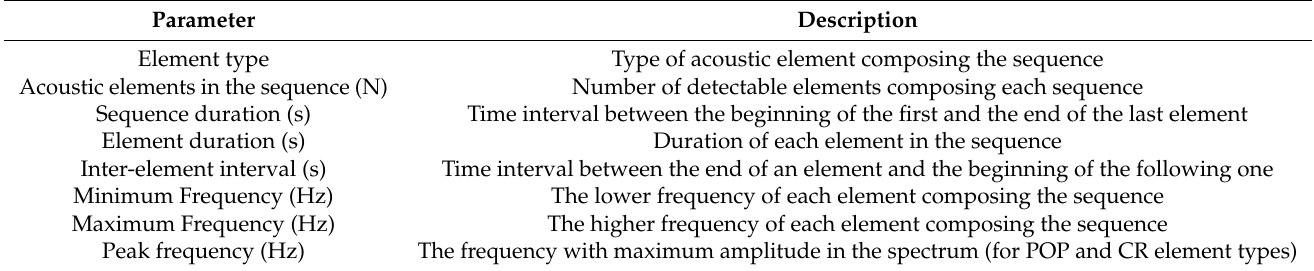
Table 2. Definition of acoustic parameters measured for each bray call series and for each single element composing the sequence.